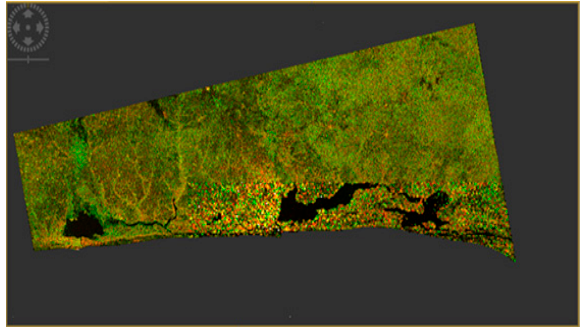
Figure 2. RGB composites for Dual Pol.